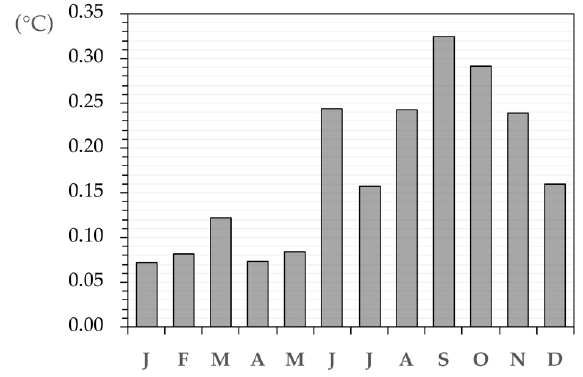
Figure 5. Monthly average differences ( ° C ) between SST derived from AVHRR and MODIS calculated from a 9-year series covering the entire study area (WMed).